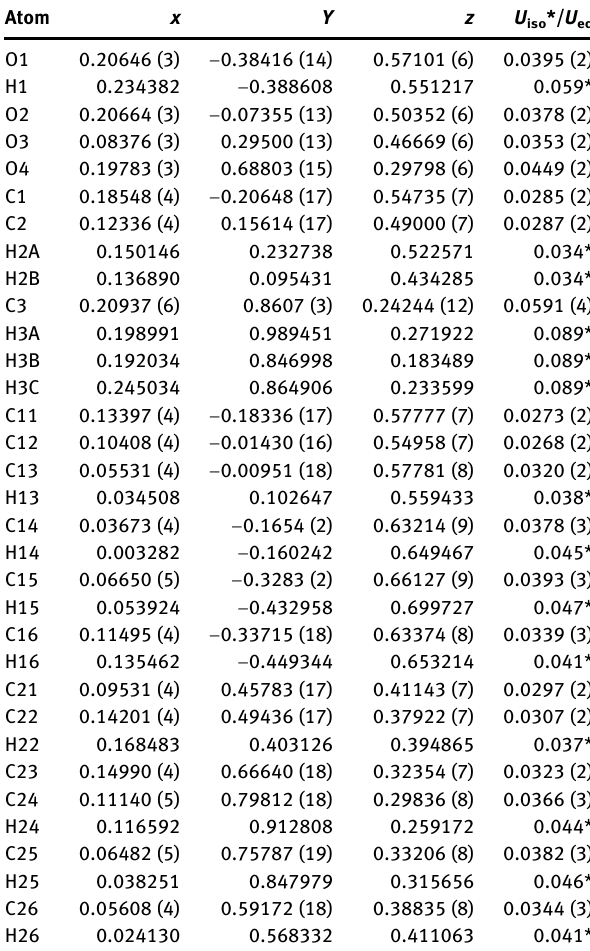
Table  : Fractional atomic coordinates and isotropic or equivalent isotropic displacement parameters (Å  ).